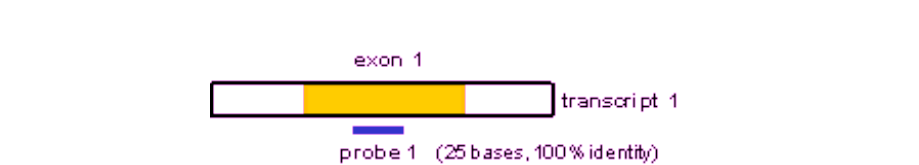
Figure 1: An example of a probe considered to be mapping uniquely to an exon. Probe 1 aligns to only one place in the exon with 25 bases (100% identity) and nowhere else.